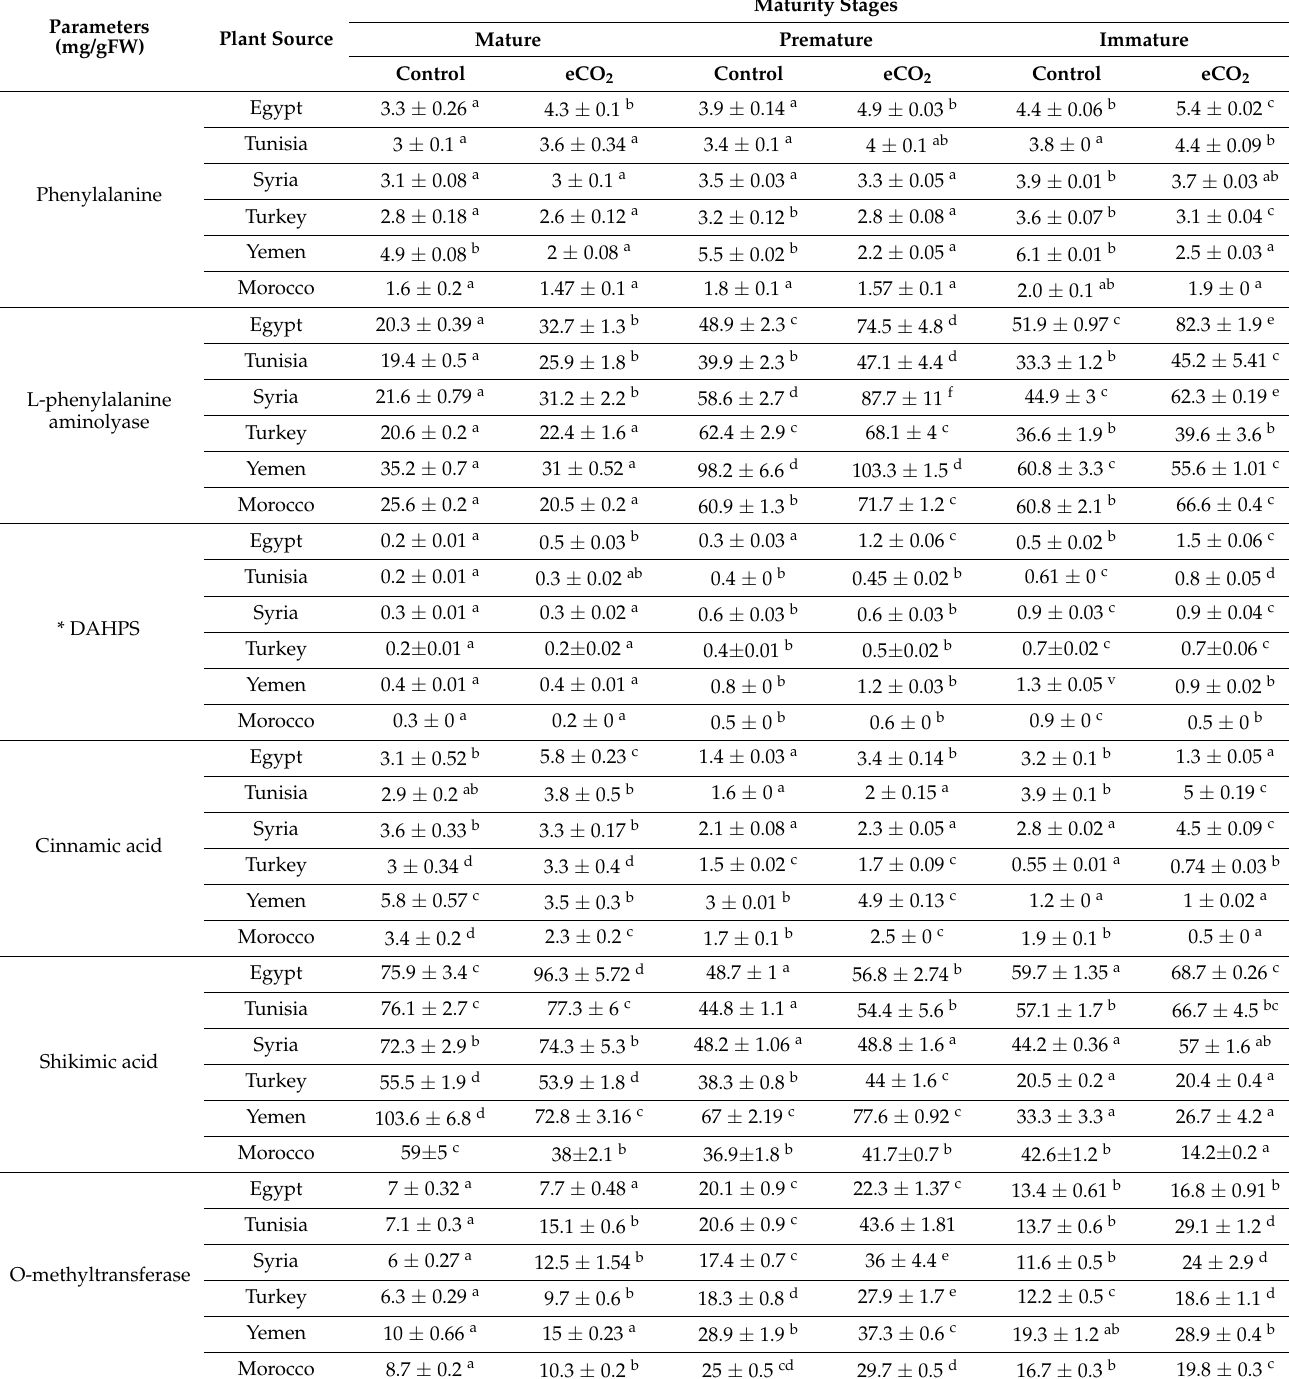
Table 2. Essential oil-related precursors and related enzyme activities of six Pimpinella anisum L. accessions at three seed developmental stages and under control and elevated CO 2 (eCO 2 ) growth conditions. Data are represented by the means of at least 5 replicates ± standard error. Different small letter superscripts within a row indicate significant differences between control and eCO 2 -treated samples at p <